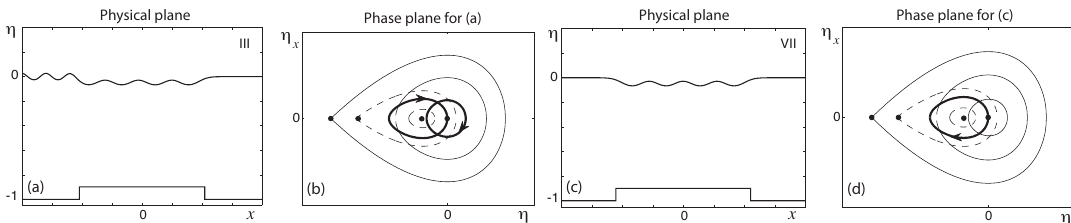
Figure 9. Hybrid subcritical flow past a long bump, with F < 1, h > 0 and B (cid:29) 0 [50,56]. ( a , b ) Flow type III. ( c , d ) Flow type